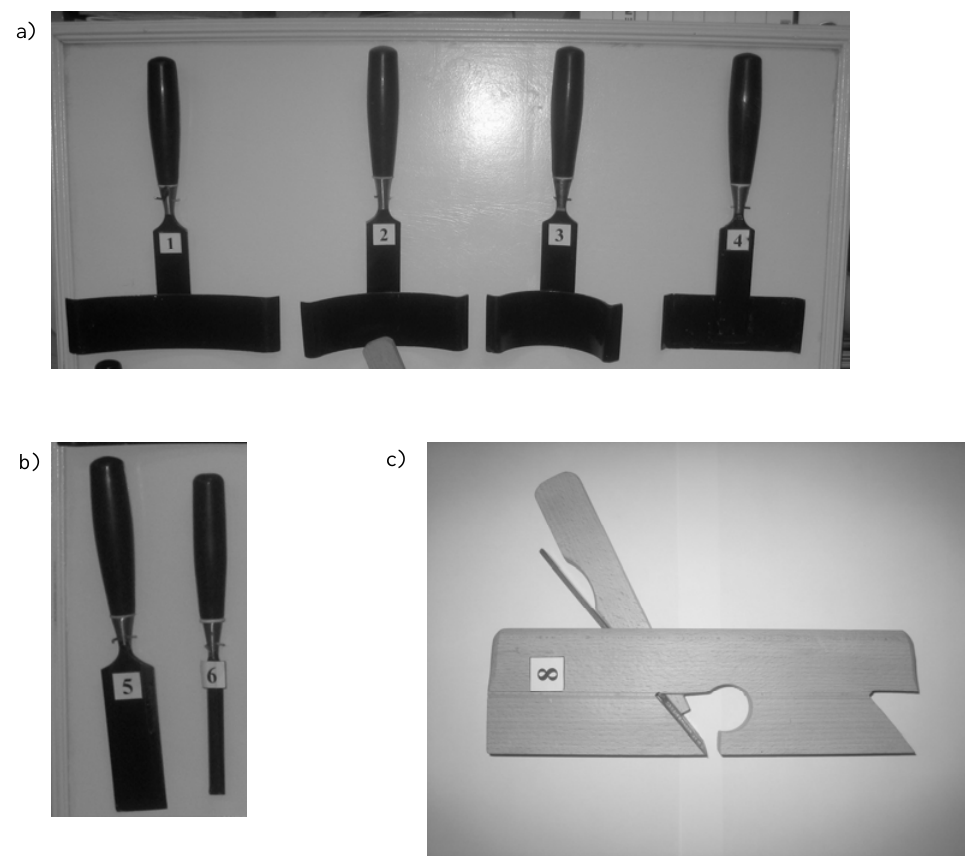
Fig. 3. Produced tree-ring sampling equipment: a) No 1, 2, 3, 4 – arched